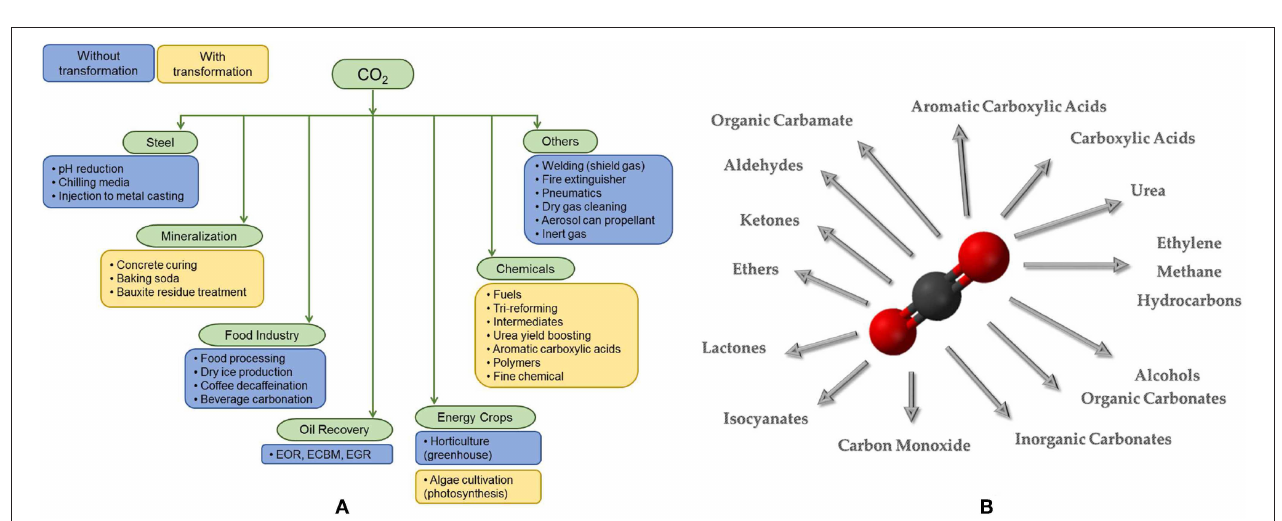
FIGURE 2 | (A) CO 2 utilization alternatives. (B) Synthetic processes for some products obtained from CO 2 , divided into